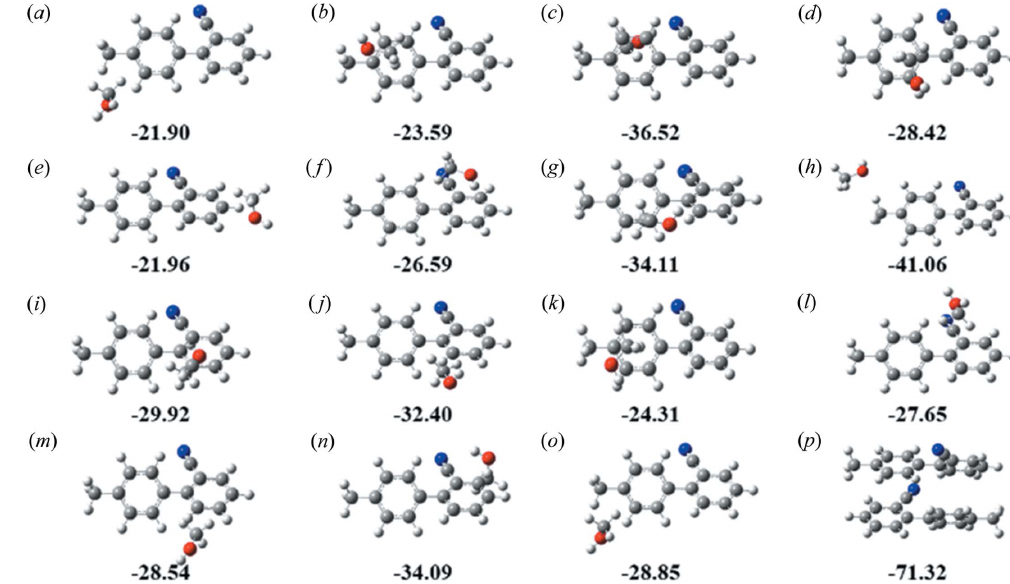
Figure 2 Optimized geometries and binding energies of 1:1 OTBN–methanol complexes and the OTBN dimer for each stable configuration.